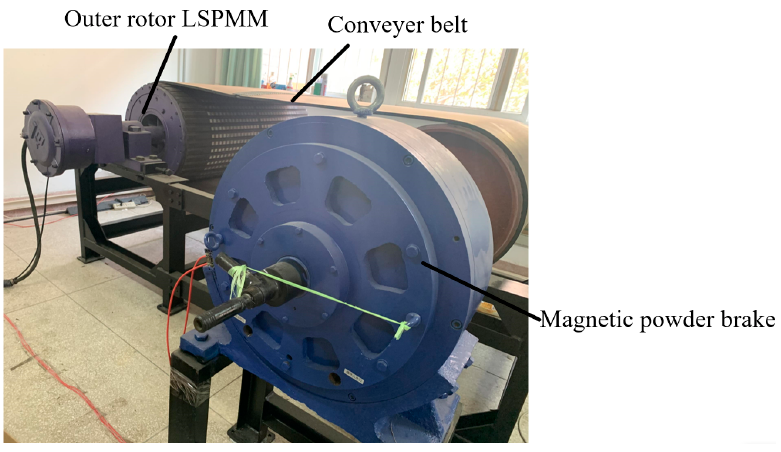
Figure 22. Prototype. Figure 22.